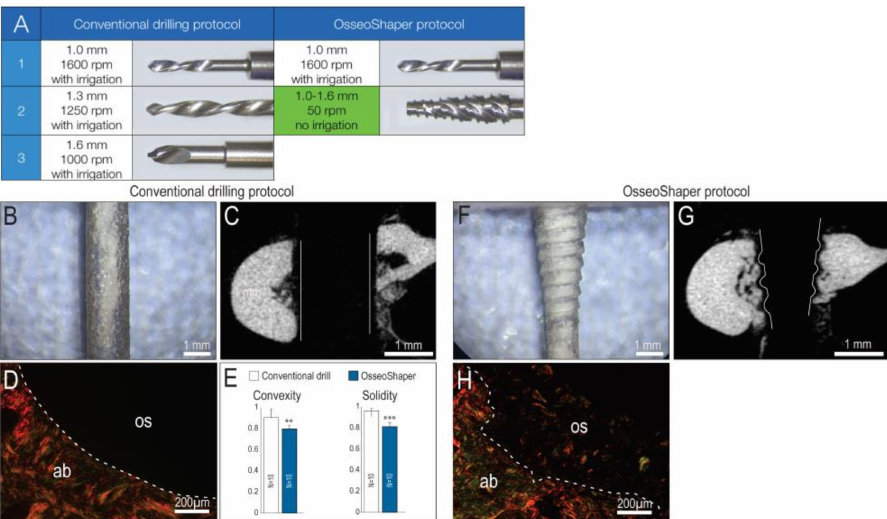
Figure 1. Osteotomy site preparation with OsseoShaper requires fewer steps and, unlike conventional drills, produces a rough surface. ( A ) All osteotomy site preparations began with the use of a 1.0-mm pilot drill run at 1600 rpm plus irrigation; afterward, the conventional osteotomy procedure used a 1.3-mm drill (1250 rpm plus irrigation) followed by a 1.6-mm drill (1000 rpm plus irrigation). The OsseoShaper protocol used the same 1.0-mm pilot drill at 1600 rpm plus irrigation, and was then followed by the OsseoShaper run at 50 rpm without irrigation. Using a conventional drill ( B ) in plexiglass demonstrates the shape and texture of a cut surfaces, and ( C ) in bone, µ CT sections illustrate the parallel walls of the osteotomy. ( D ) Picrosirius red staining of a representative transverse tissue section demonstrates the resulting smooth cut surface. ( E ) Quantification of surface texture, as expressed by convexity and solidity, resulting from a conventional drilling protocol. Using an OsseoShaper ( F ) in plexiglass demonstrates a tapered shape with a threaded surface, ( G ) which is validated by µ CT imaging. ( H ) Picrosirius red staining of a representative transverse tissue section demonstrates the textured cut surface and the retention of collagen containing osseous coagulum. Solid and dotted lines show the edge of the osteotomy. Two asterisks indicate p < 0.01. Three asterisks indicate p < 0.001. Scale bars ( B , C , F , G ) = 1 mm, and ( D , H ) = 200 µ m. Abbreviations: ab, alveolar bone; os,